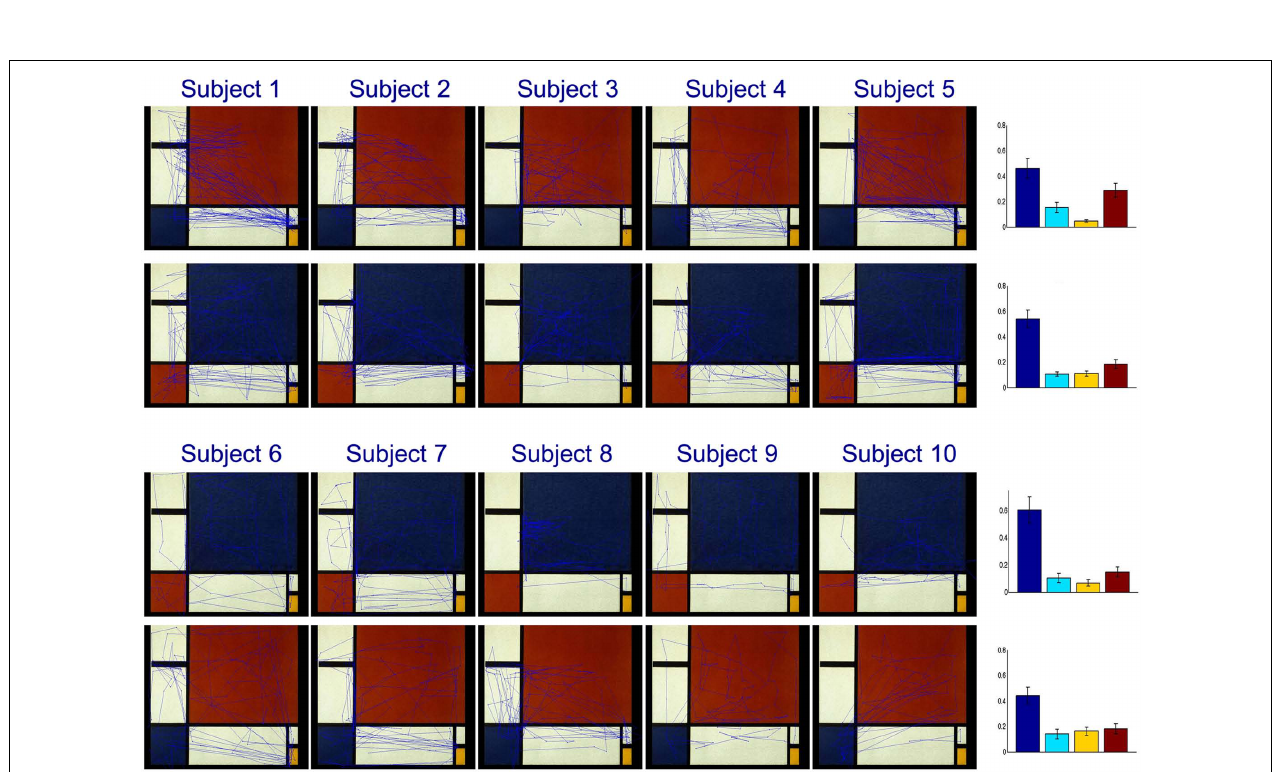
FIGUREA2 | Saccade patterns for all 10 subjects looking at the original and modified versions of “Composition II in red, blue, and yellow” by Mondrian. The upper (lower) two rows show the subjects that looked at the